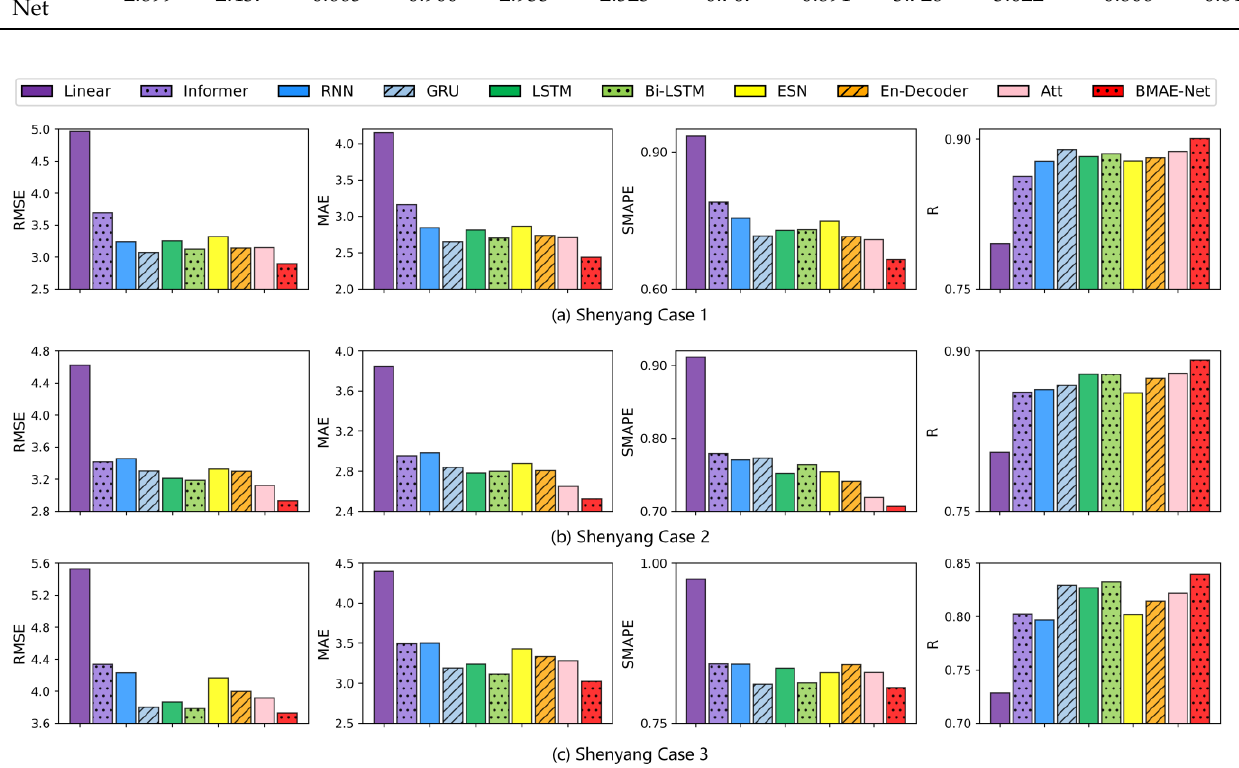
Figure 5. Bar graph of the temperature forecast evaluation index for the Shenyang station. Table 3. Experimental results for temperature from the Shenyang station. The results of the temperature experiments in the Beijing area are shown in Table 4. As can be seen from Table 4 and Figure 6, the RMSE, MAE, and SMAPE indicators of the model proposed are lower than the other baseline models, which indicates that the model exhibits the smallest difference between the prediction and the ground truth. The R indicators are greater than in the other models, indicating that the model has the highest goodness of